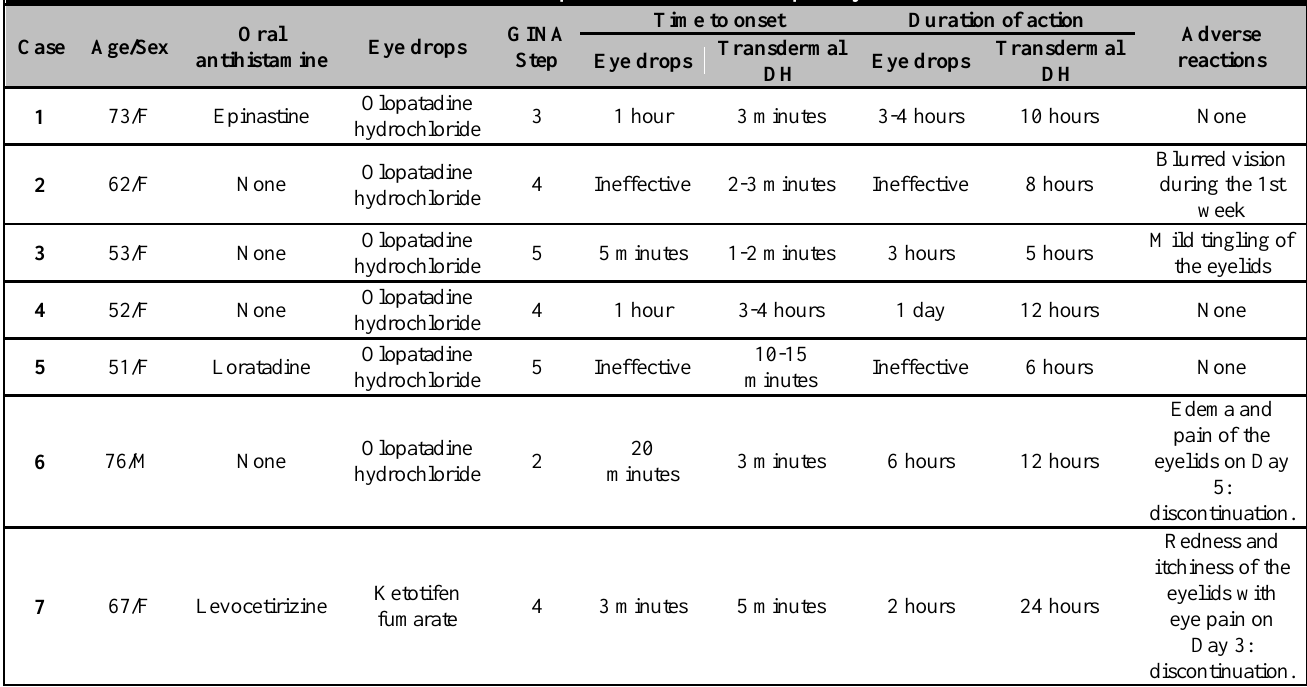
Table 1. Characteristic of the patients and effects of diphenhydramine